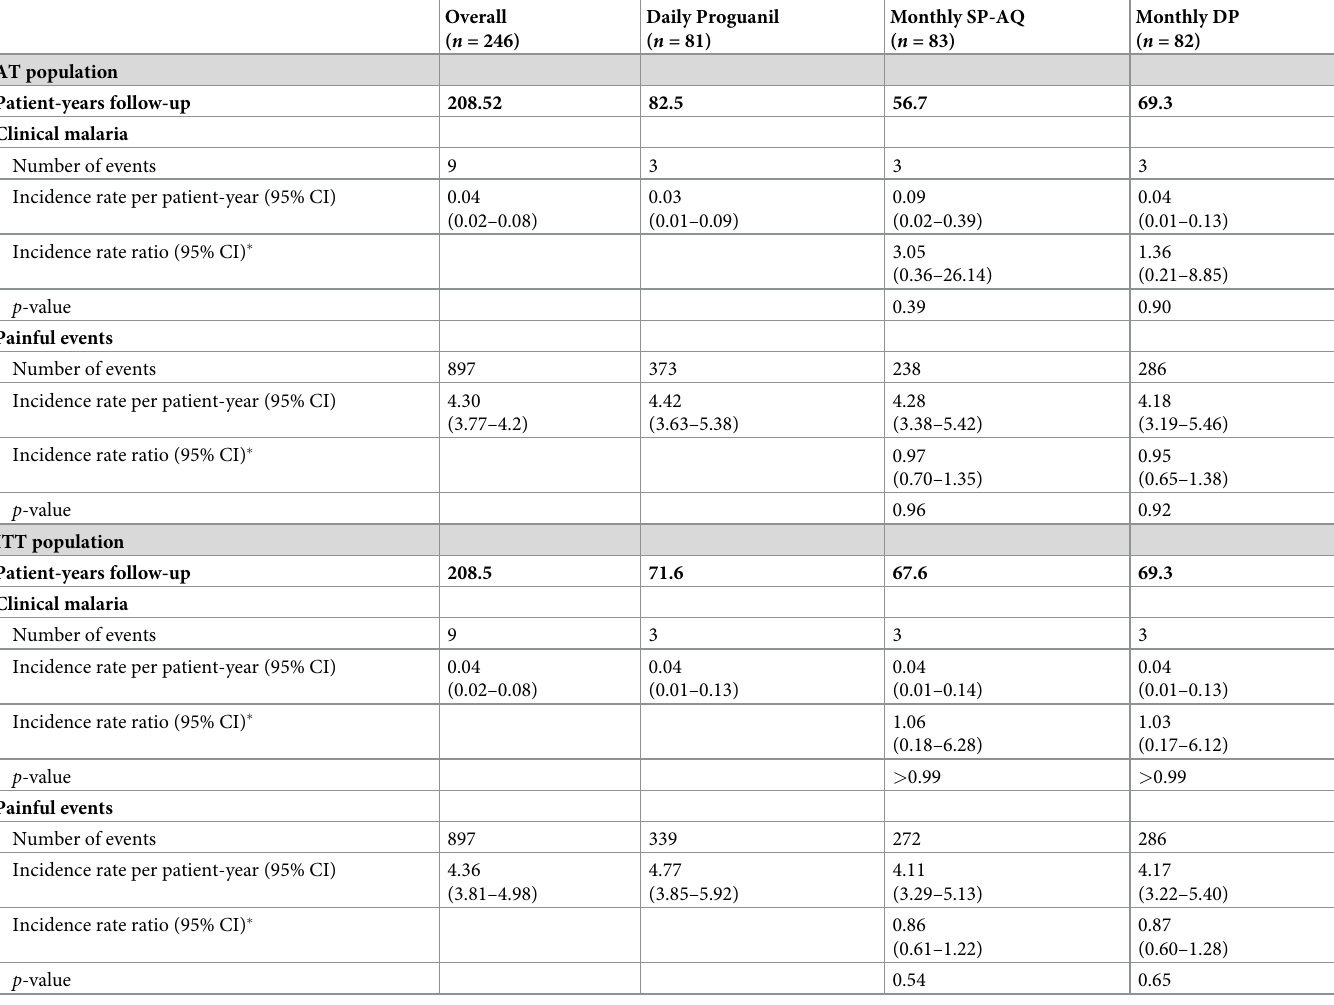
Table 2. Main parasitologic and hematologic